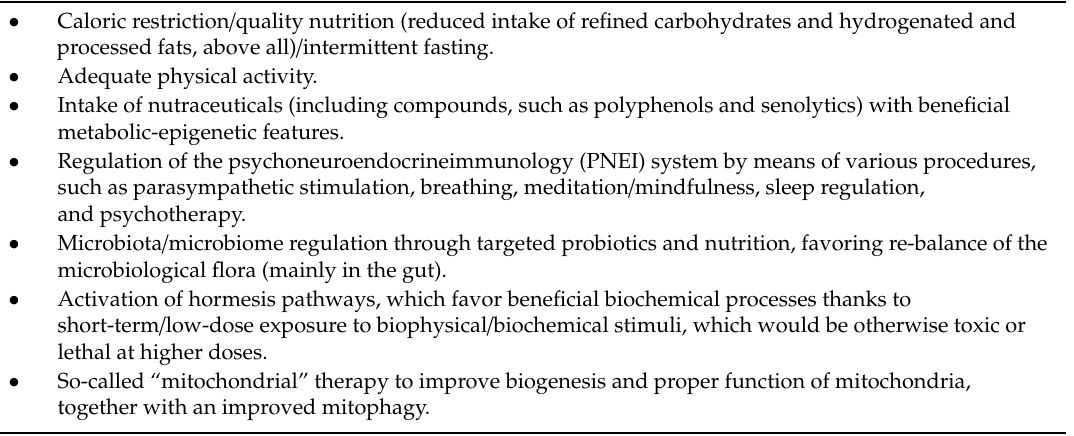
Table 2. Integrative medicine